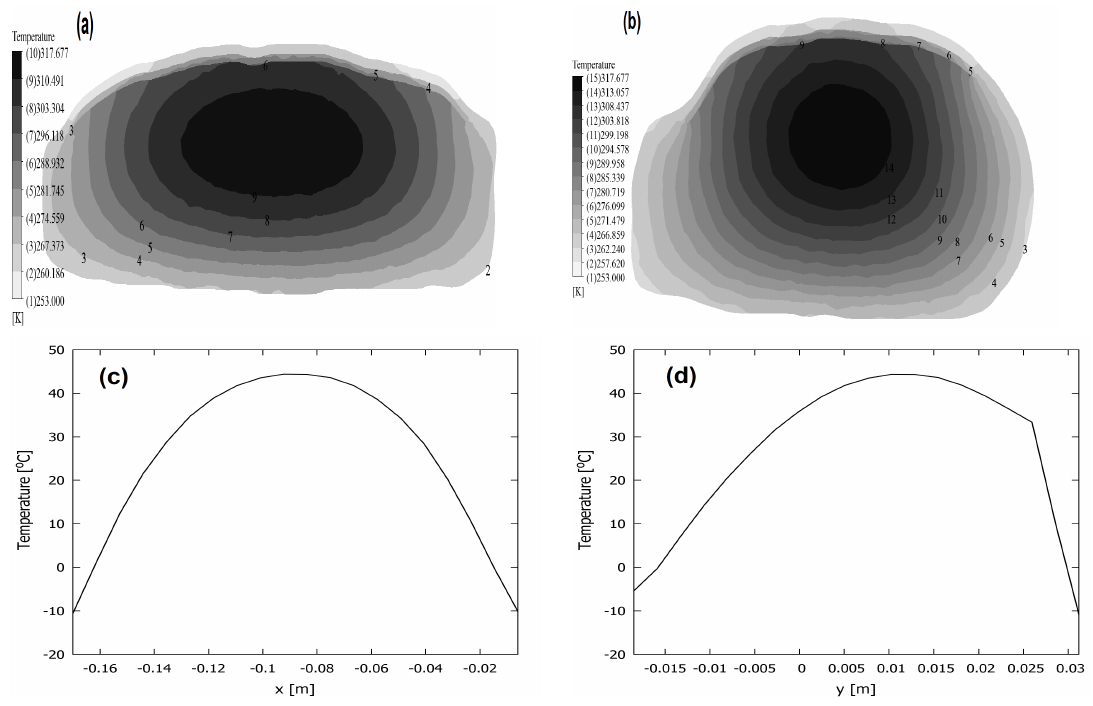
Figure 8. ( a , b ) represent the temperature contours across the length and width planes respectively, the numbers on the contours are referring to the values of the temperature on the legend. ( c , d ) represent the temperature profiles at horizontal in x -direction (length of pasty is 186 cm) and vertical in y -direction (the thickness of pasty is 5.1 cm) lines crossing the region of high temperature on the